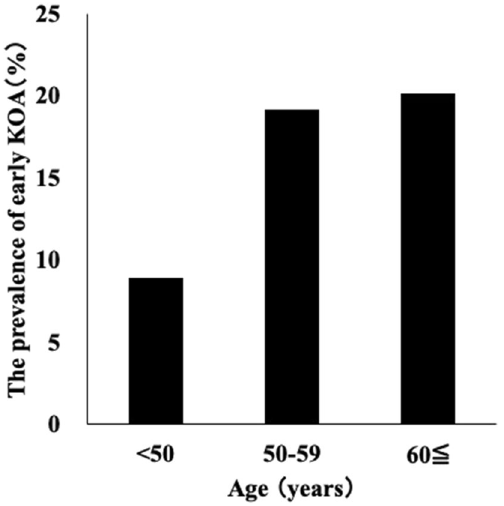
Figure 2. The prevalence of early knee osteoarthritis (KOA) classified by age.